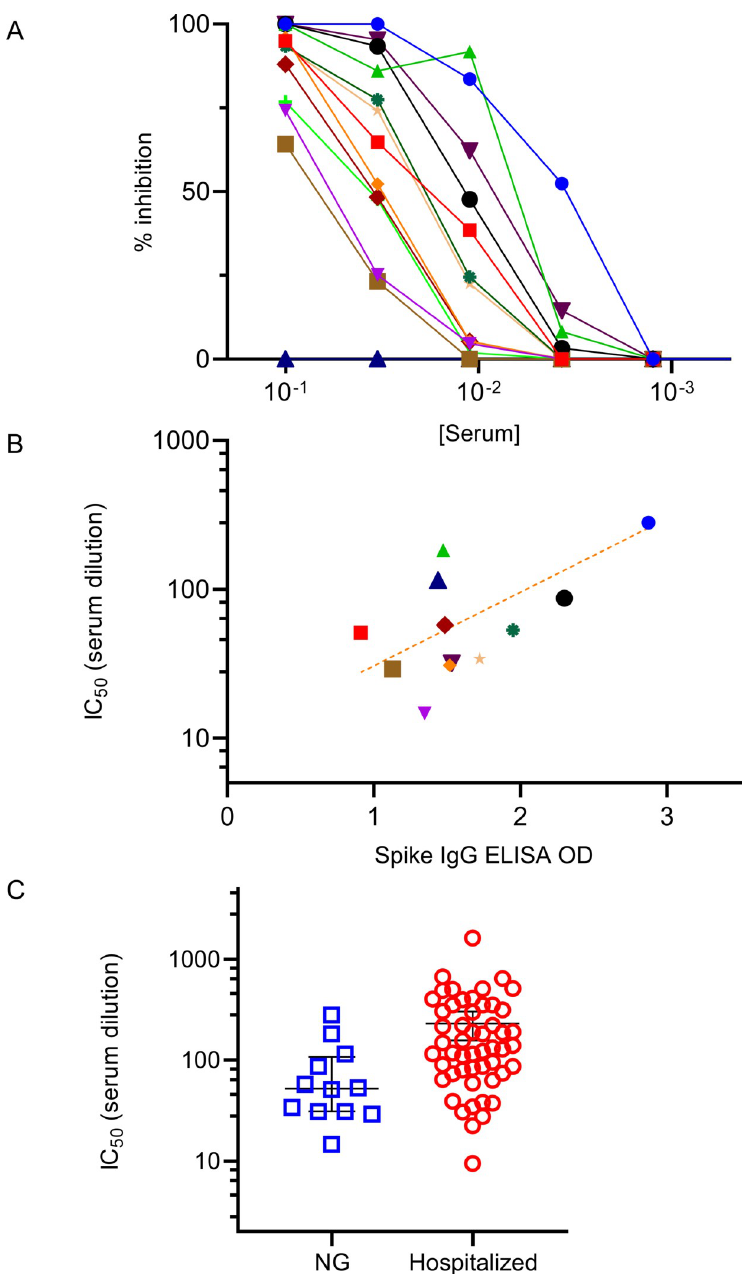
Fig 4. Neutralizing capacity of serum from individuals with mild/asymptomatic COVID-19, not requiring hospitalization. (A) Serum was titrated in a live viral plaque assay to measure neutralization capacity (% inhibition of plaque formation) expressed on the Y axis vs. serum concentration (X-axis). Different color line/symbol represents data from a single subject with ID# shown in key in upper right, and negative control (blue triangles). (B) Correlation between the IC 50 (Y-axis) and the spike IgG ELISA OD values (X-axis). Each symbol represents the average of replicate data points from a single individual in key above. r 2 = .567 for the best fit trend line, log(y) = .495x + 0.991. (C) Comparison of serum neutralizing activity, IC 50 (Y-axis) of the present National Guard troops (NG) vs. hospitalized study subjects recently published [21]. Each symbol represents data from a single subject’s serum titration. The mean and standard error for the different groups of study subjects is